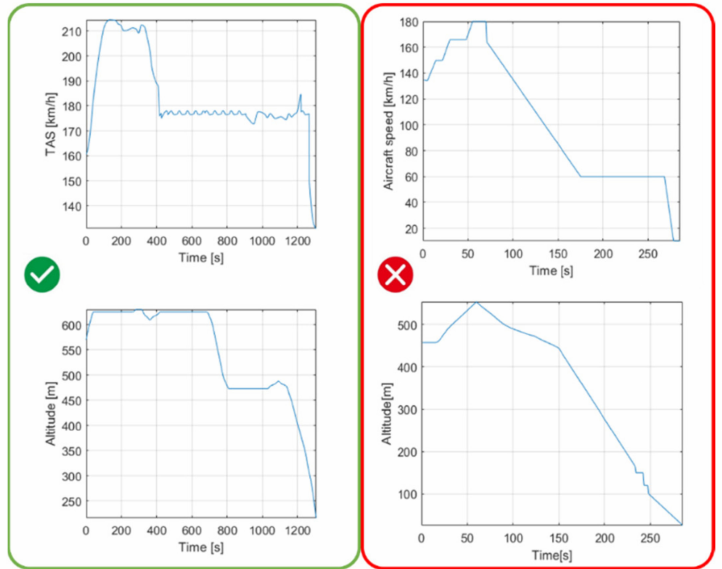
Figure 11. Mission profiles for normal operation ( left ) and engine failure ( right